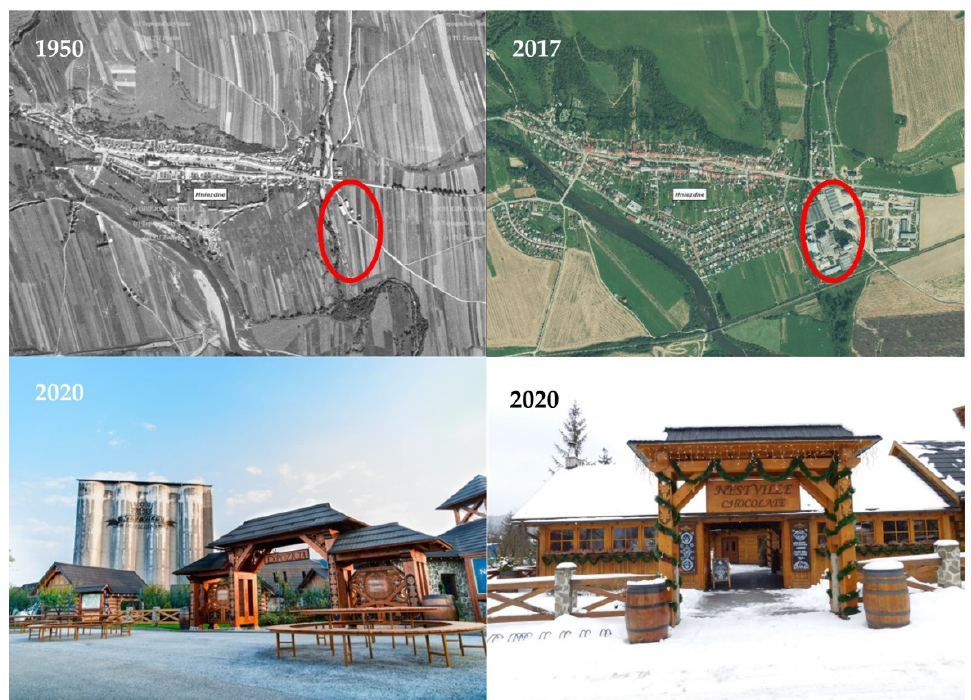
Figure 6. Visual interpretation of the Hniezdne site. Source: 1950—Adapted with permission from ref. [37]. Copyright 2021 GEODIS SLOVAKIA, s.r.o. Bratislava, Topografický ústav Banská Bystrica. 2017—Adapted with permission from ref. [38]. Copyright 2021 GKÚ Bratislava, NLC Zvolen. 2020 left—Adapted with permission from ref. [56]. Copyright 2020 BGV, s.r.o. 2020 right—author’s photo.